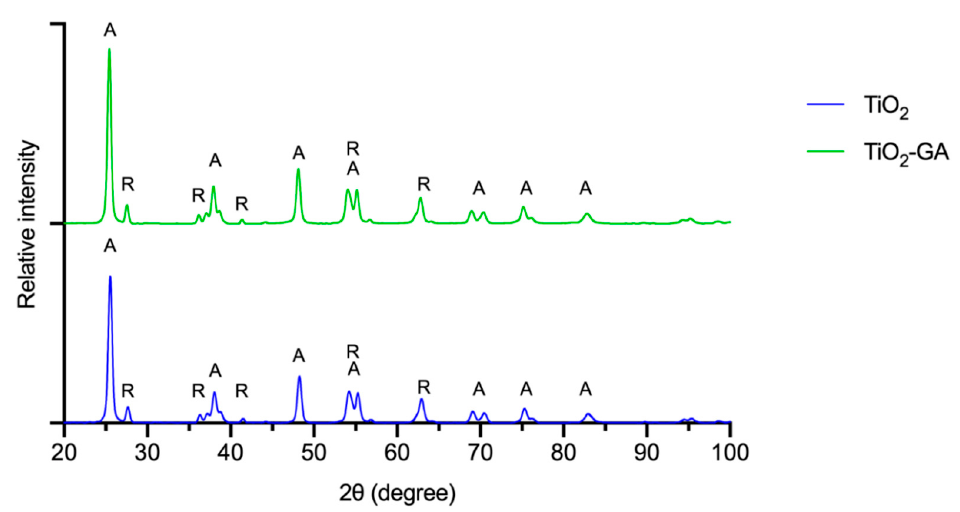
Figure 4. XRPD patterns of TiO 2 and TiO 2 -GA. Labels describe peaks belonging to anatase (A) and rutile